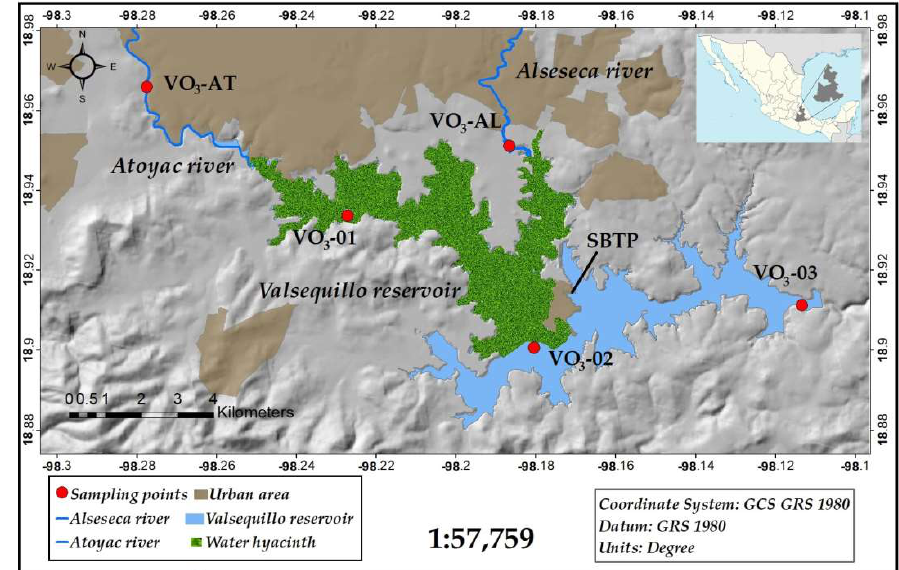
Figure 1. Sampling points in Atoyac River, Alseseca River and Valsequillo Reservoir in Puebla State, Mexico. SBTP = San Baltazar Tetela Peninsula.